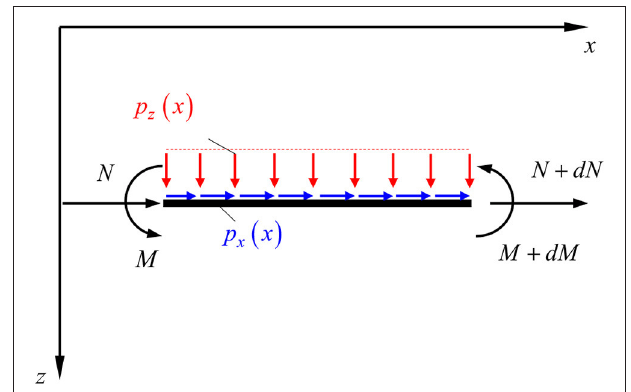
FIGURE 1 | Forces and moments acting on the